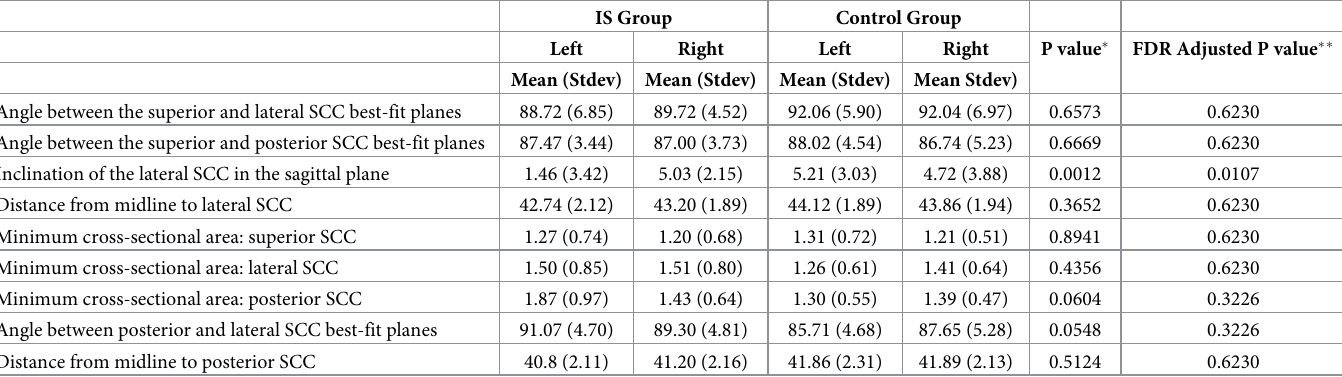
Table 2. SCC canal measurements by group and side.